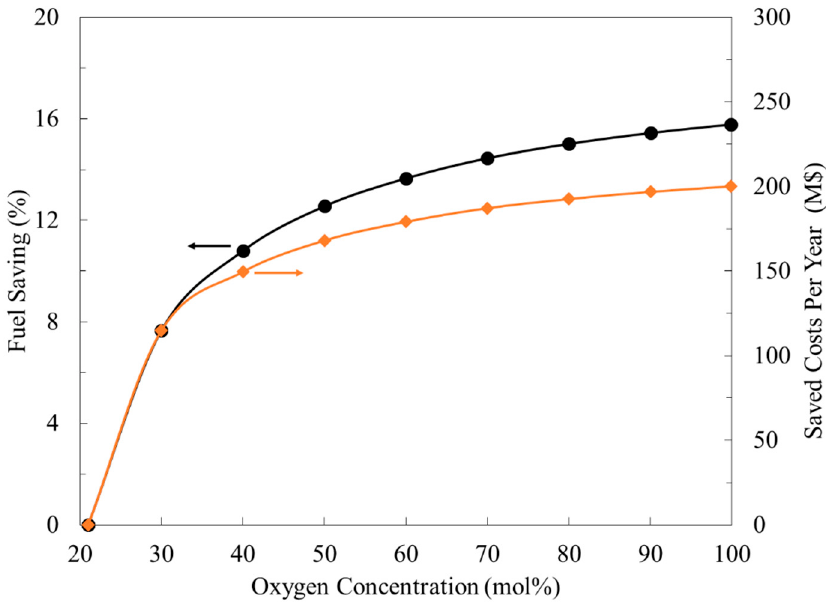
Figure 3. Enriched oxygen concentration and the corresponding natural gas fuel savings.